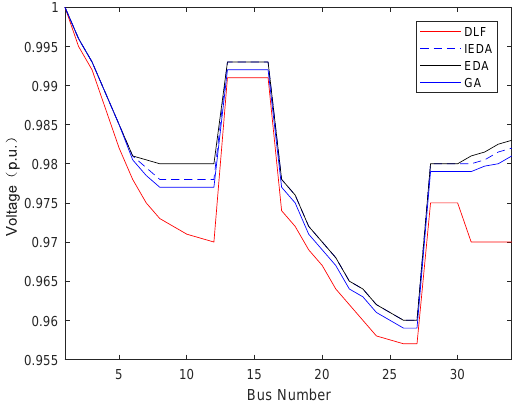
Figure 9. Voltage distribution of the 34 bus radial distribution system.